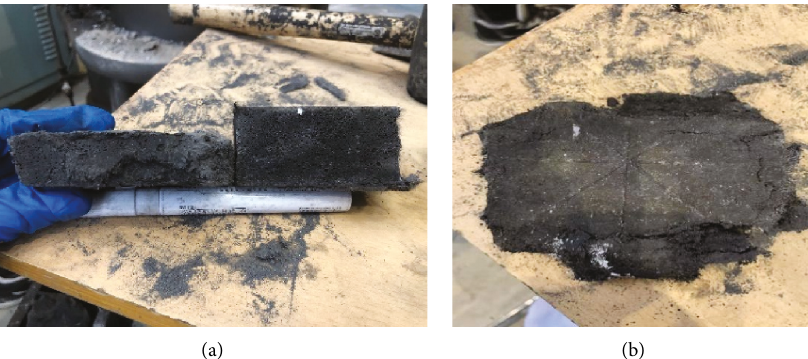
Figure 7: Specimen appearance and curve of the experimental group of “Continuous compression without obvious failure load.”